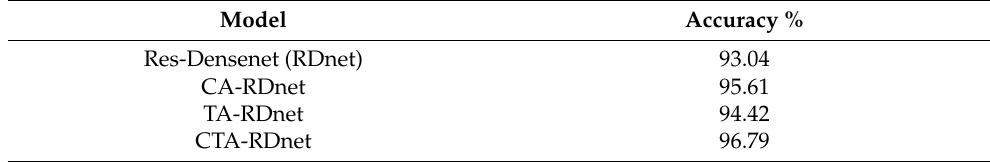
Table 6. Experimental results of the ablation